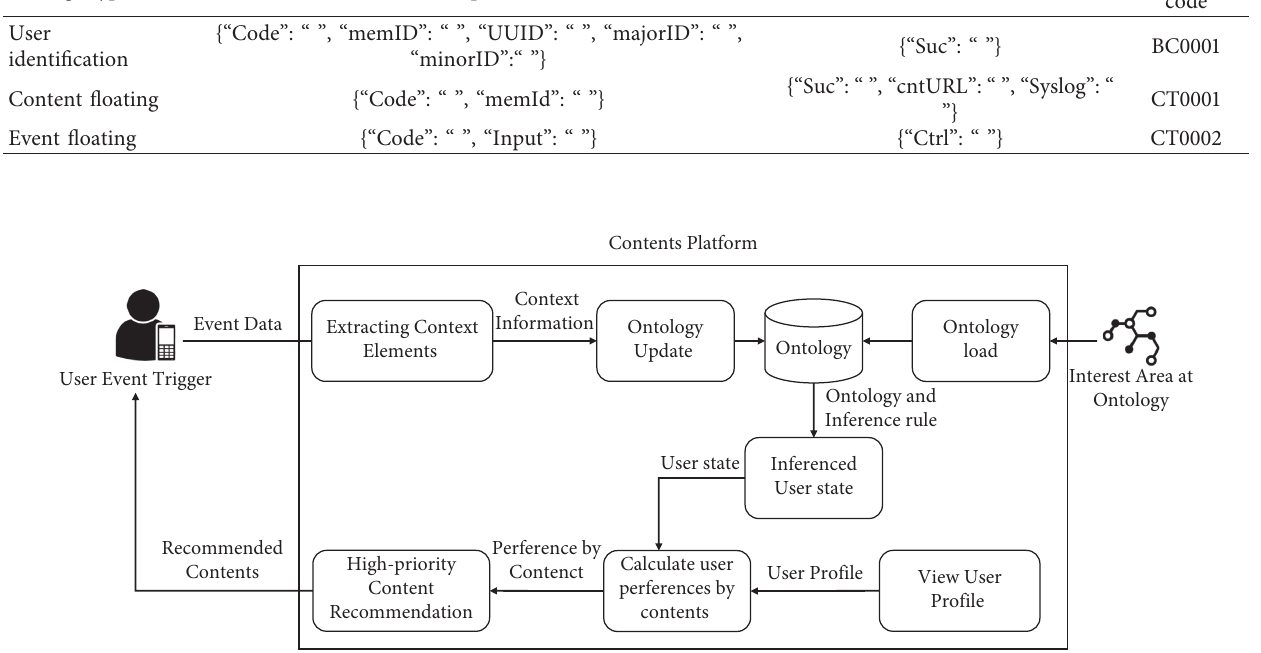
Figure 3: Recommendation of user-specific content.